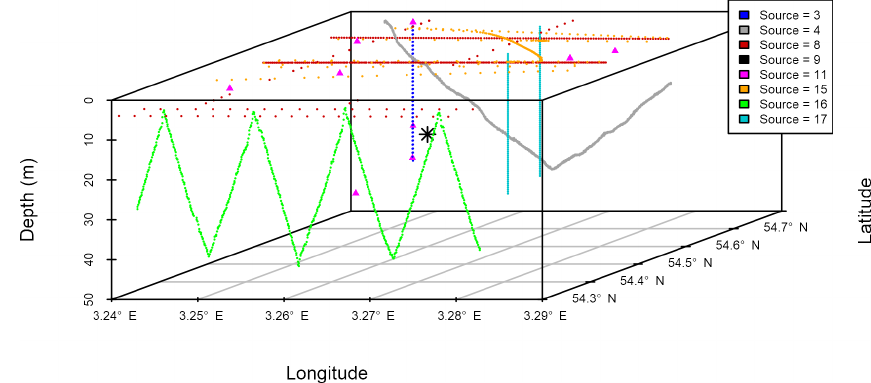
Figure 14. Selected small-scale location illustrating the diversity of data sources available and their associated depth profiles. Note that the data illustrated were not collected at the same time.